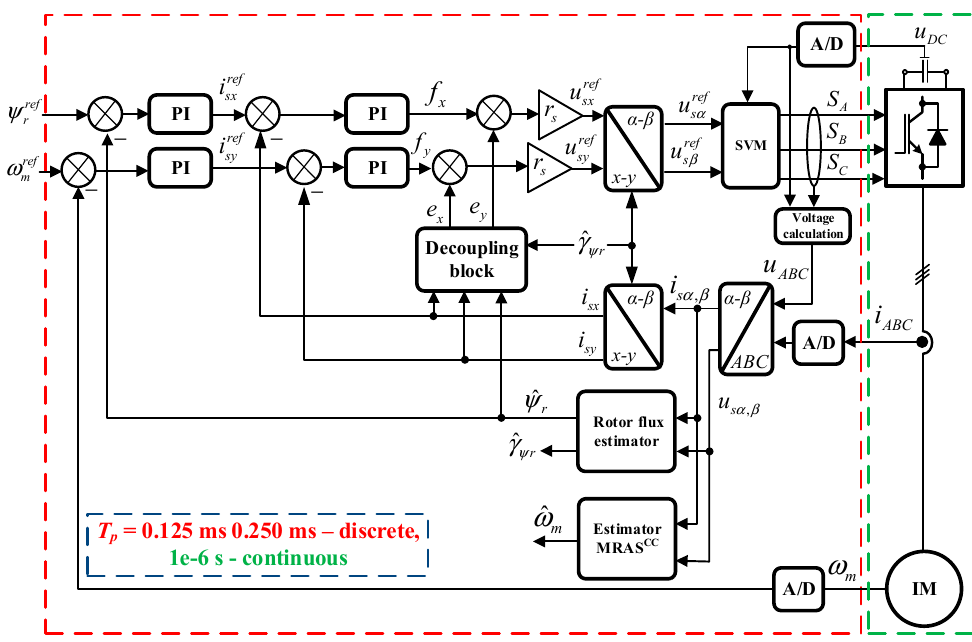
Figure 3. The scheme of the DRFOC (Direct Rotor Flux Oriented Control) structure.